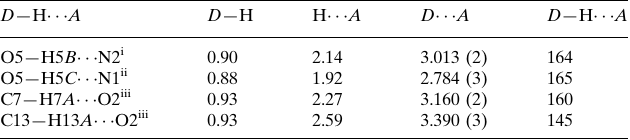
Hydrogen-bond geometry (A˚ , (cid:3)